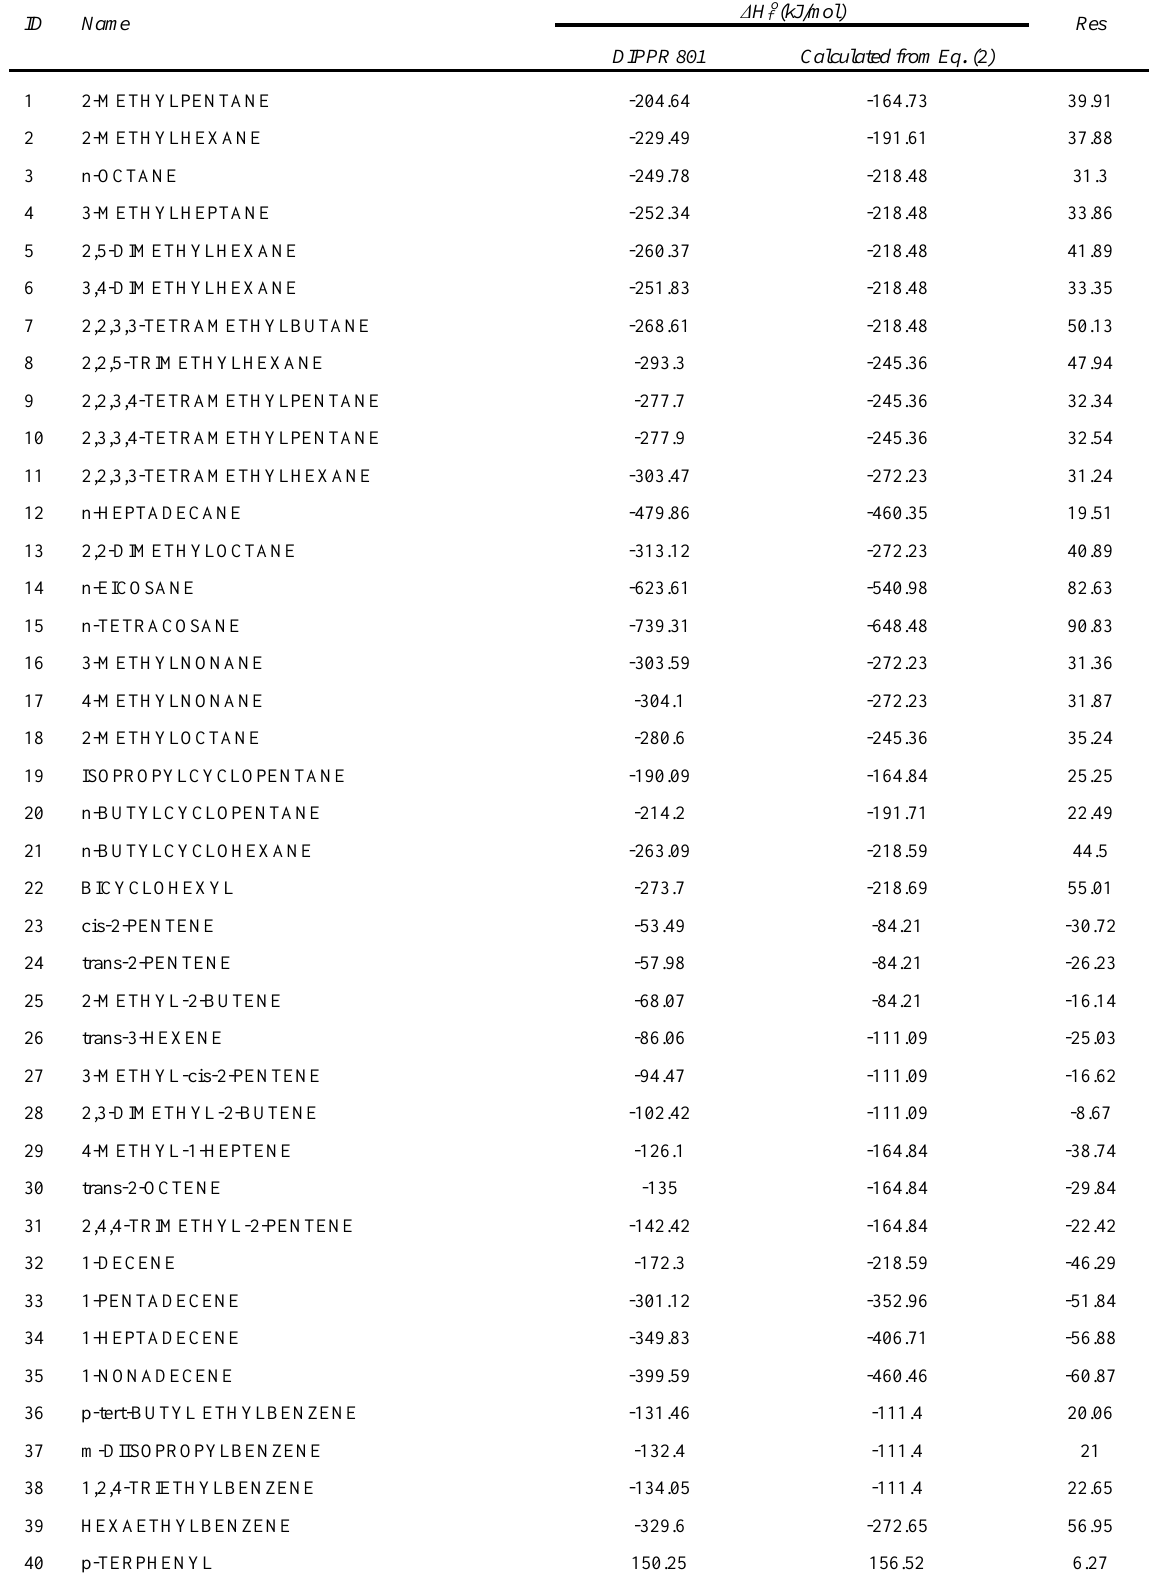
Table 4. The predicted o H D by the Eq. (2) for test set as an excluded data set f